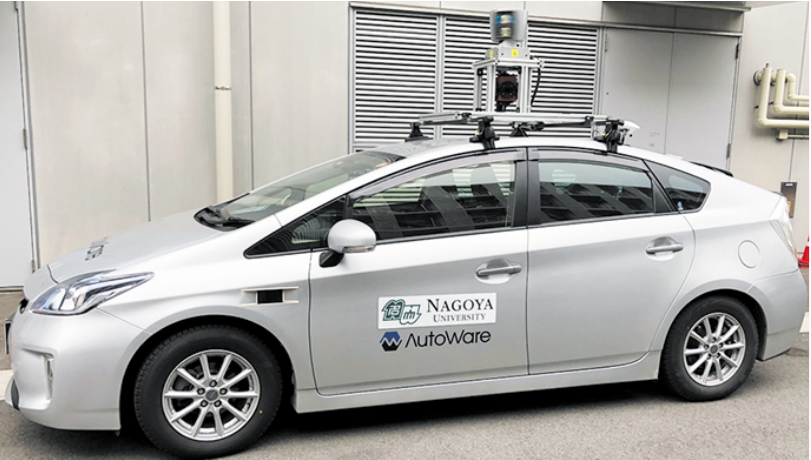
Figure 5. The experimental vehicle. For more information about the vehicle, please refer to